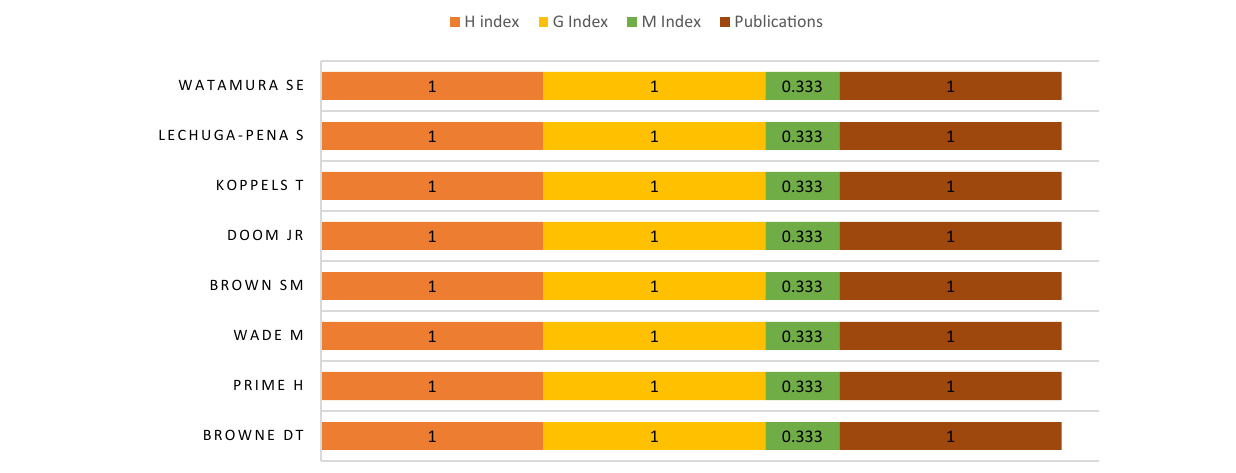
FIGURE 4 | Leading authors.